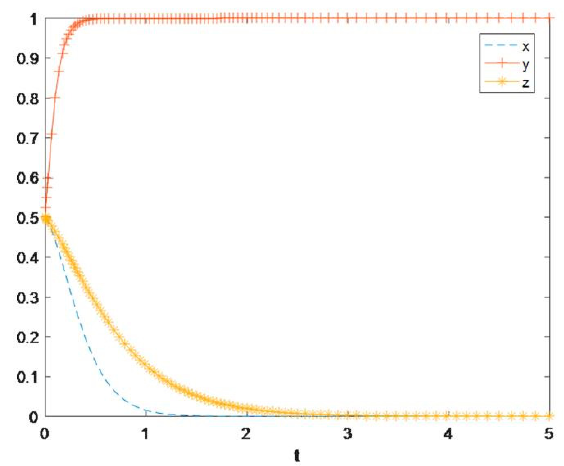
Figure 5. Two-dimensional diagram of evolutionary path at stable point (0, 1, 0).